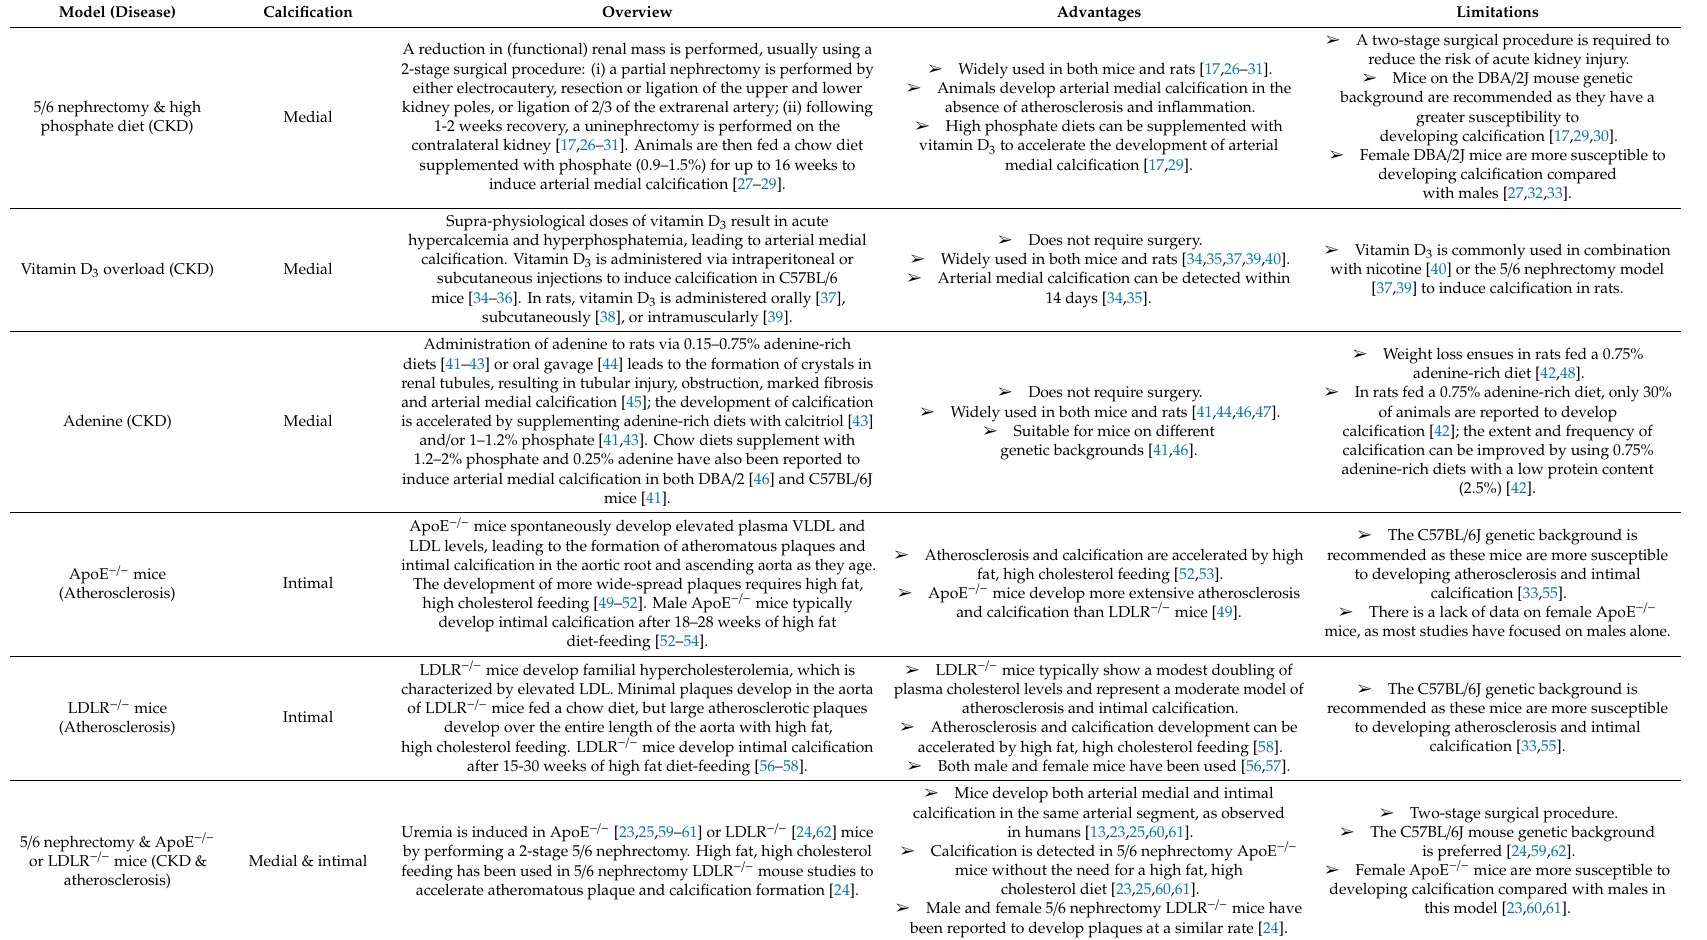
Table 1. Rodent models of vascular